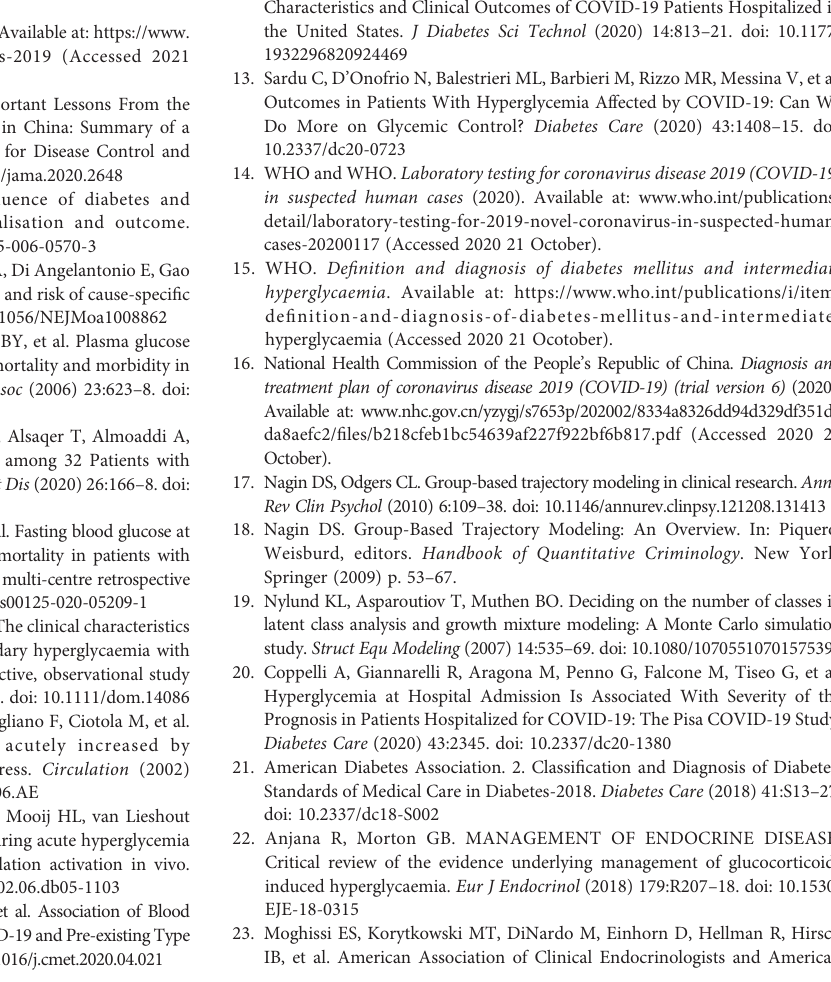
Supplementary Figure 1 | Variables selection using LASSO regression model. (A) Tuning parameters ( l ) selection in LASSO model used 10-fold cross-validation via minimum criteria. (B) LASSO coef fi cient pro fi le of 42 clinical features (age, sex, 8 treatments, and 32 laboratory indices). Supplementary Figure 2 | Relationship between changes in fasting blood glucose levels and the monitoring time in survivors and non-survivors. Supplementary Figure 3 | Visual correlation matrix of glycemic variations and theevolutionofbiochemical parameters. This fi gureprovides avisualrepresentation of the respective correlations as measured using Pearson ’ s correlation coef fi cients (r), based on P =0.05. The color-intensity signal indicates correlation strength, whereas the blue and red colors indicate strong positive and negative correlations, respectively. * <0.05. (A) The metrics (columns) represent biochemical parameters inbloodroutinetest. (B) Themetrics(columns)representbiochemicalparameters in hepatic and renal function tests. (C) The metrics (columns) represent biochemical parameters in coagulation function